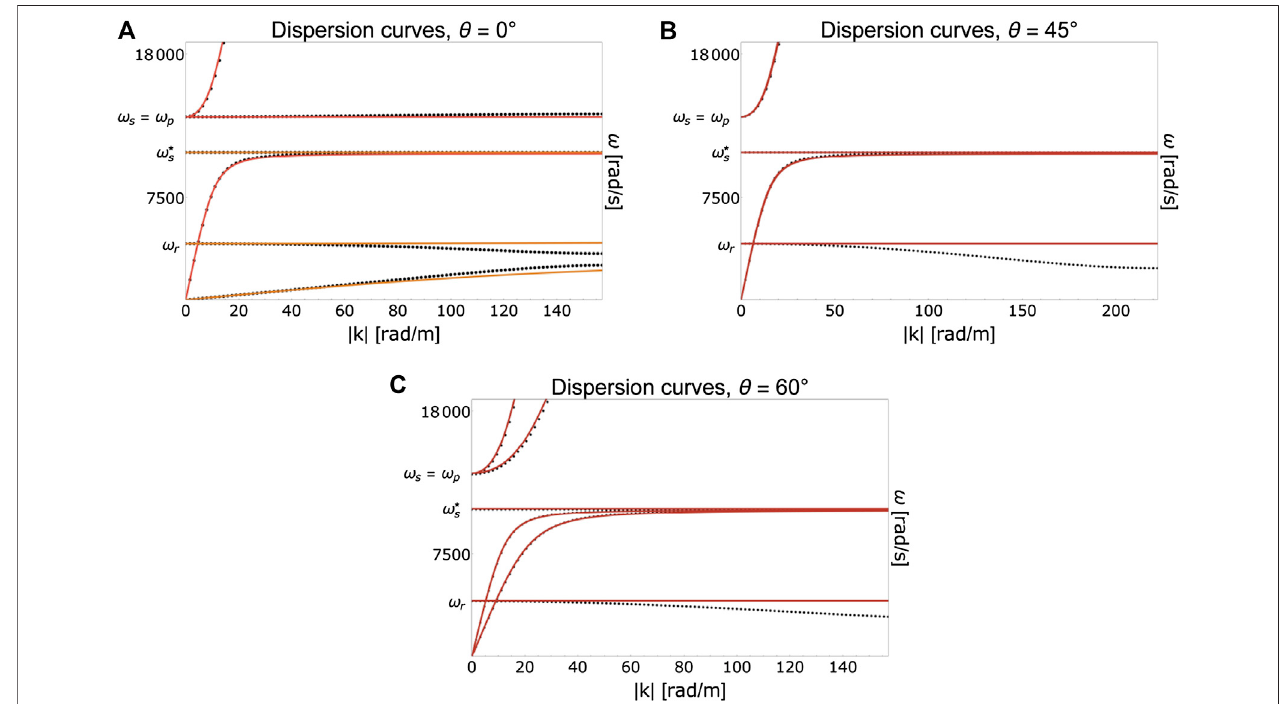
FIGURE 3 | Dispersion curves for the metamaterial MM1 corresponding to three different direction of propagation (A) θ (cid:2) 0 + , (B) θ (cid:2) 45 + , and (C) θ (cid:2) 60 + .